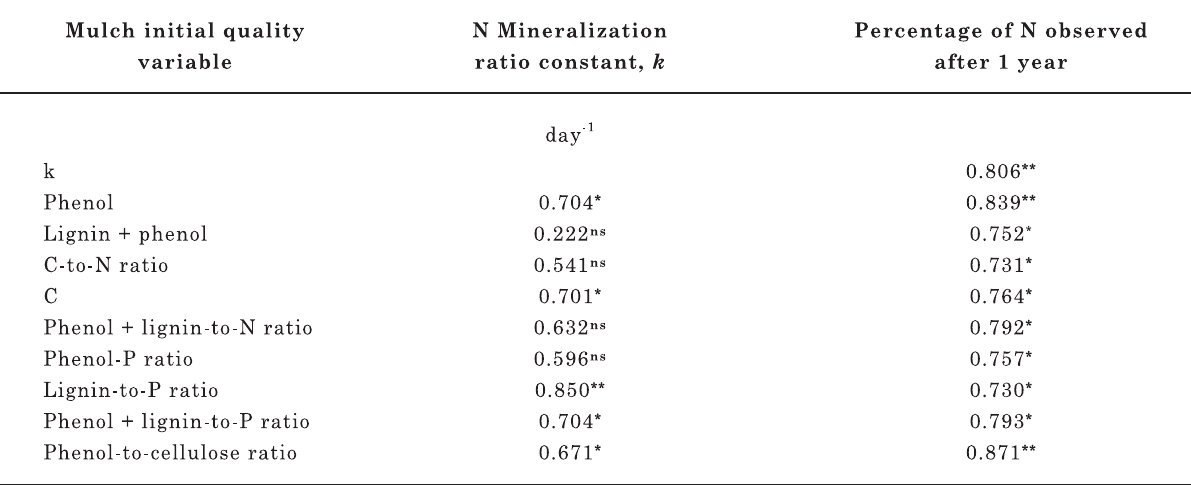
Table 3. Coefficients of determination (r 2 ) for linear regressions between initial substrate quality variables from some legumes species and natural fallow vegetation (as control) and N mineralization rate constants after one year of field decomposition